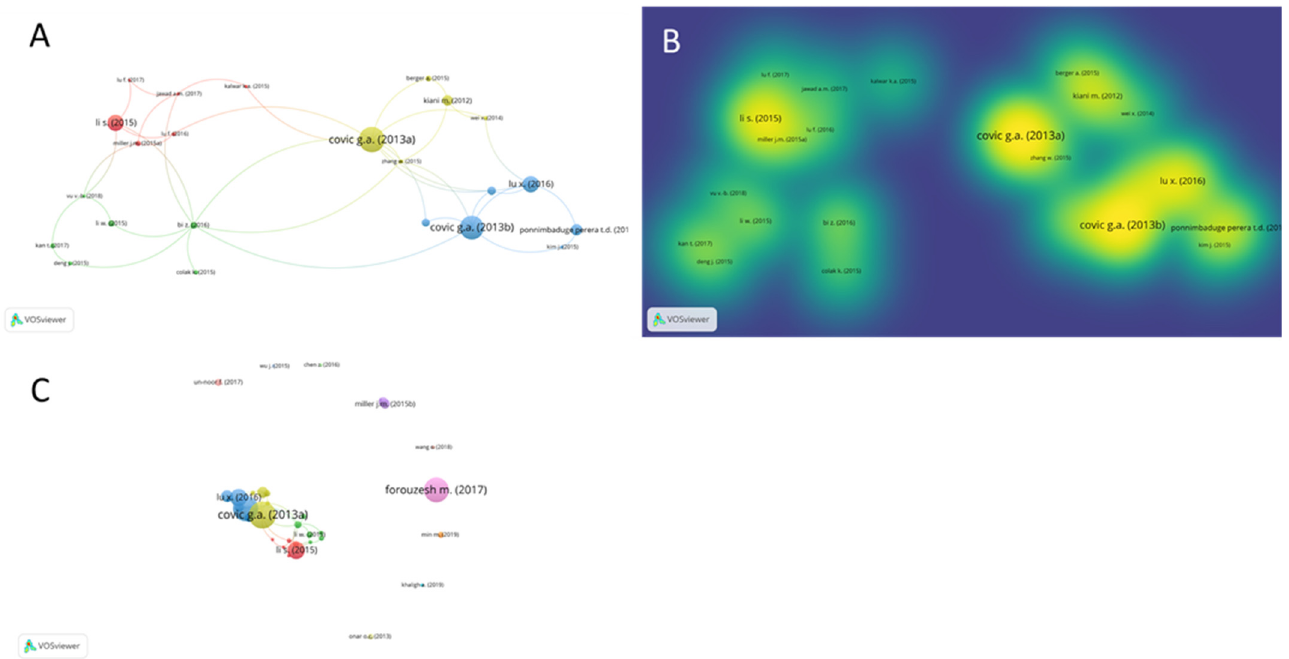
Figure 12. Citation network for documents. Network visualization ( A ) and density map ( B ) show 23 out of 1367 sources that met the threshold of 100 citations per document. There were five clusters and 41 links. The connected cited documents surrounded by unconnected cited documents are depicted in ( C ).